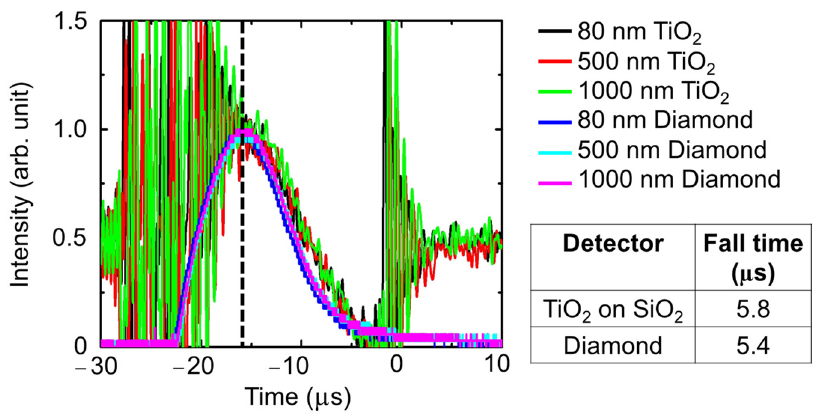
500 nm, and 1000 nm.